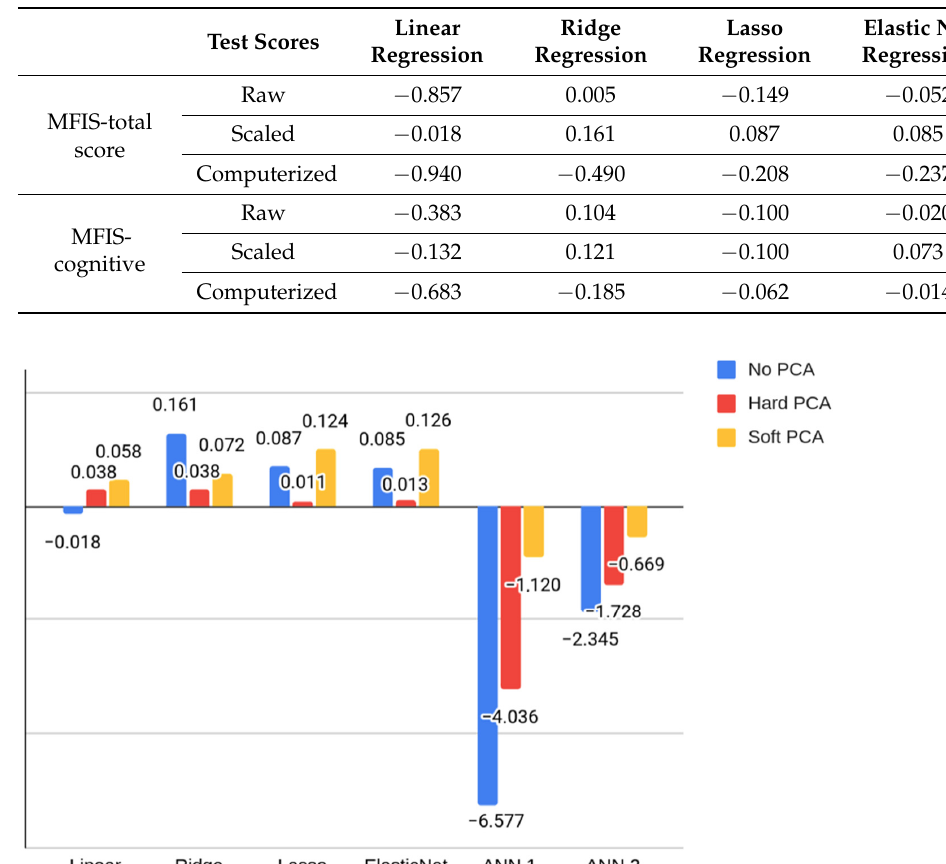
Figure 3. R 2 scores for each Modified Fatigue Impact Scale regression model (linear, ridge, lasso, elastic net, ANN 1, and ANN 2) for each feature reduction type (no principal component analysis [PCA], hard PCA, soft PCA). The negative section of the vertical axis is not represented to scale with the positive section to improve the visualization of values. Table 4. R 2 scores of the regression models for predicting Modified Fatigue Impact Scale (MFIS) score for each feature reduction